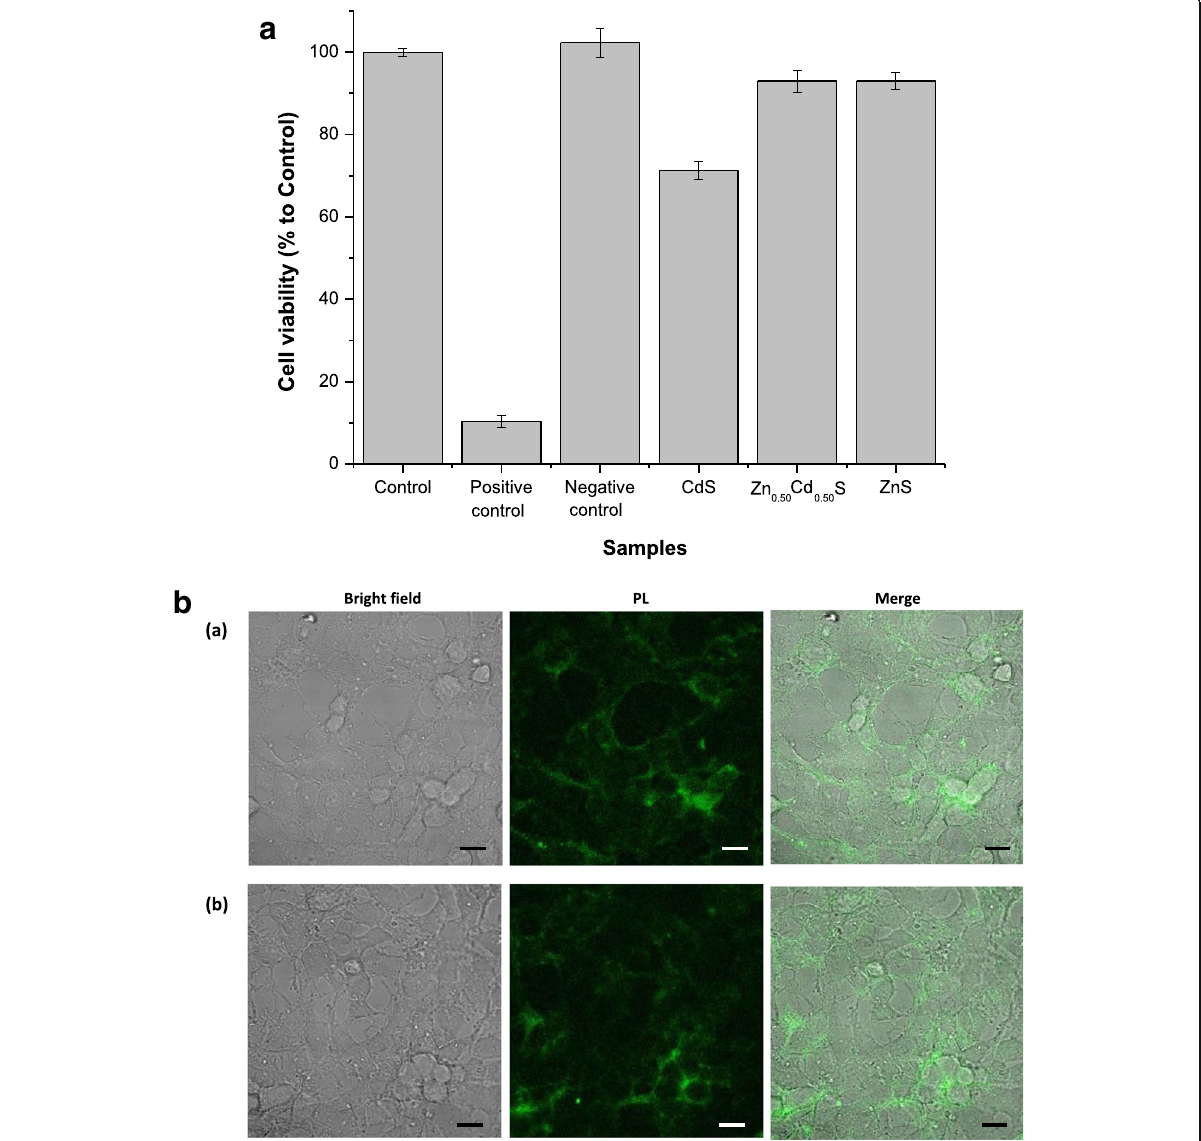
Fig. 9 MTT cell viability in vitro assay of conjugates. a MTT cell viability assay of HEK293T cells after 120 h of contact of cells with ZnS, Zn 0.50 Cd 0.50 S, and CdS conjugates. b Confocal microscopy imaging of the internalization of the (a) Zn 0.50 Cd 0.50 S and (b) ZnS conjugates in the HEK293T